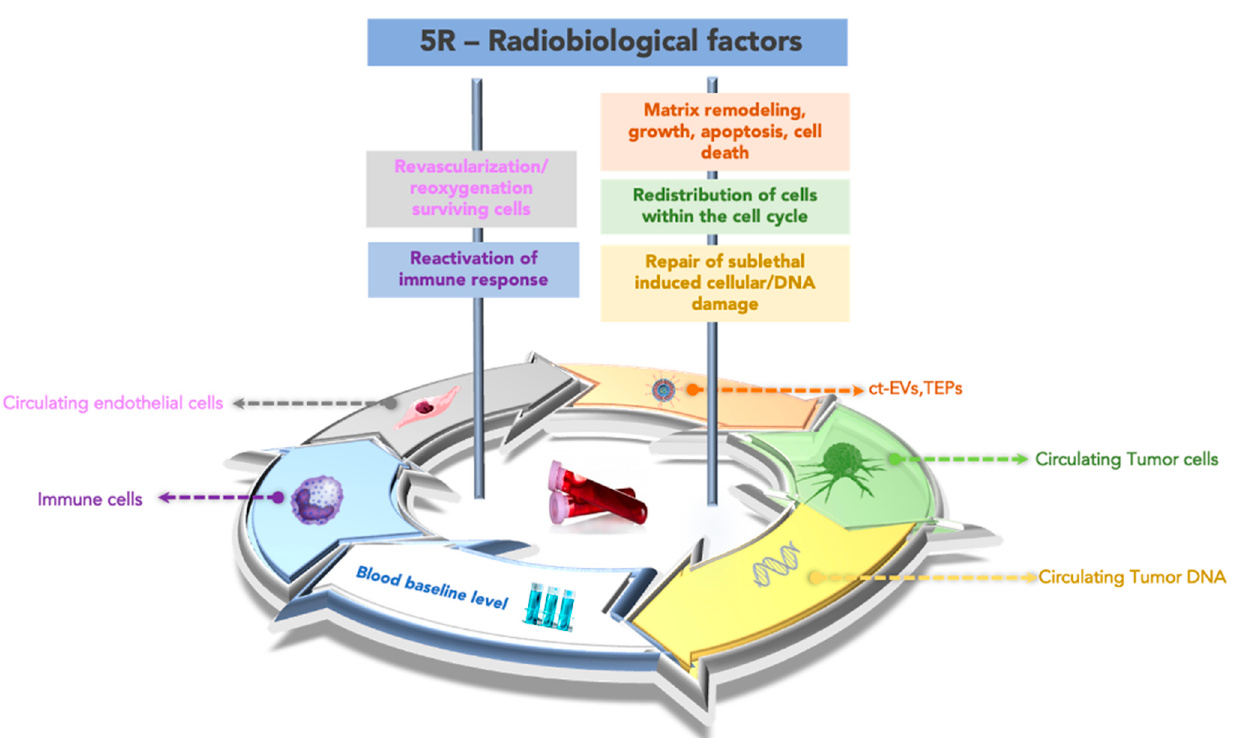
Figure 3. The “liquid redundancy” of the 5R biological factors. A proof of concept to individuate the circulating biomarkers linked to the prevalent biological factor, within the 5R, induced by interventional oncology treatment, influencing the relative effectiveness. Note: ct ‐ RNA, circulating tumor RNA; ct ‐ EVs, circulating vesicles TEPs, tumor ‐ educated platelets.